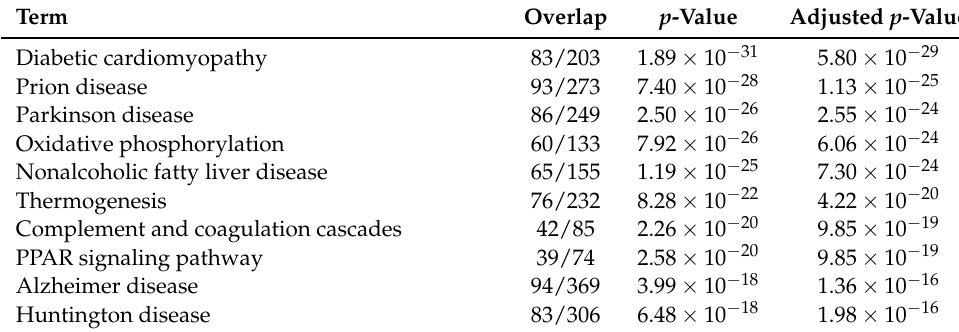
Table 1. Top 10 “KEGG 2021 Human” category terms in